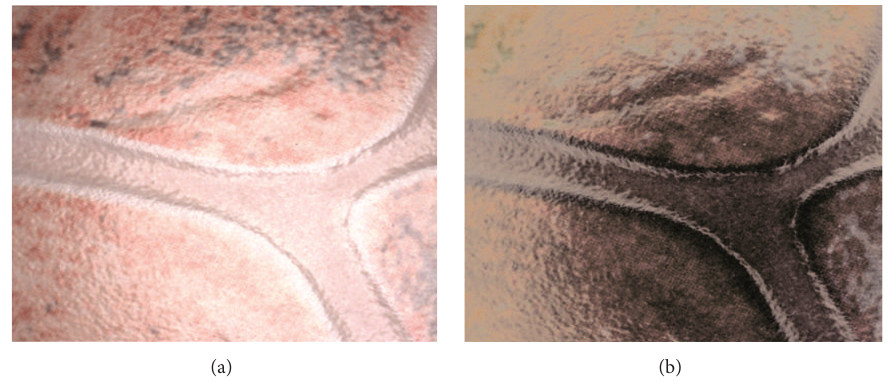
Figure 10: The images of ceramic tile. (a) Before calibration and (b) after calibration.